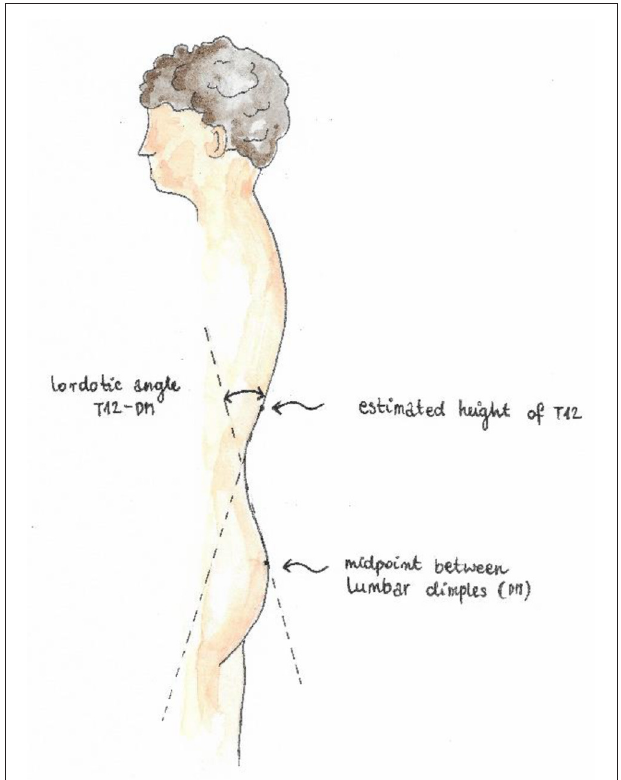
FIGURE 7 | Lordosis angle.